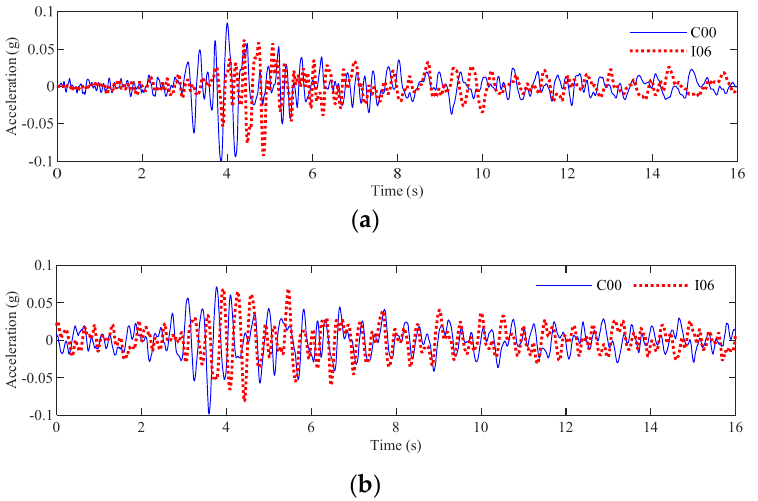
Figure 20. Comparison between measured and simulated acceleration: ( a ) Tested acceleration C00 and I06. ( b ) Simulated acceleration C00 and I06.